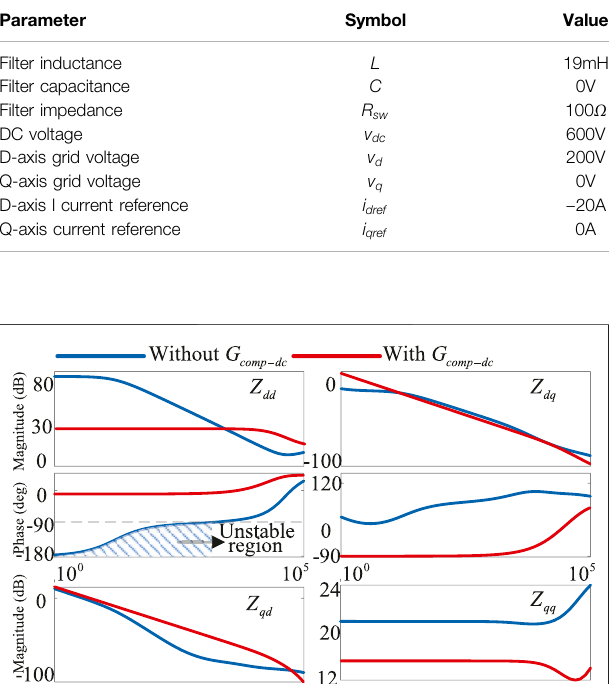
TABLE 1 | Grid-Connected system parameters.